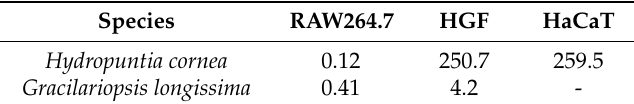
Table 2. Values of EC 50 (mg mL − 1 ) in cell lines of murine macrophage RAW264.7, HGF-gingival fibroblasts, and human HaCaT-keratinocyte for the species Hydropuntia cornea and Gracilariopsis longissima . The cells were treated with different extract concentrations (0–10 mg mL − 1 ) for 72 h and evaluated by the MTT assay.